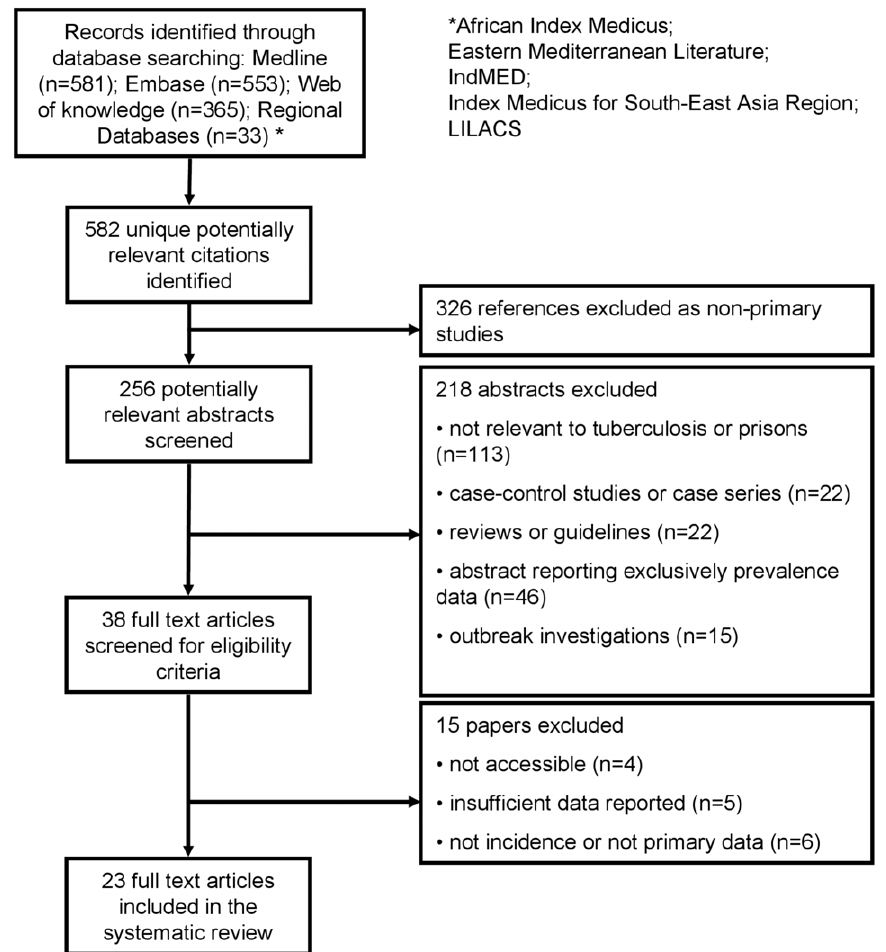
Figure 1. Flow diagram for study selection.